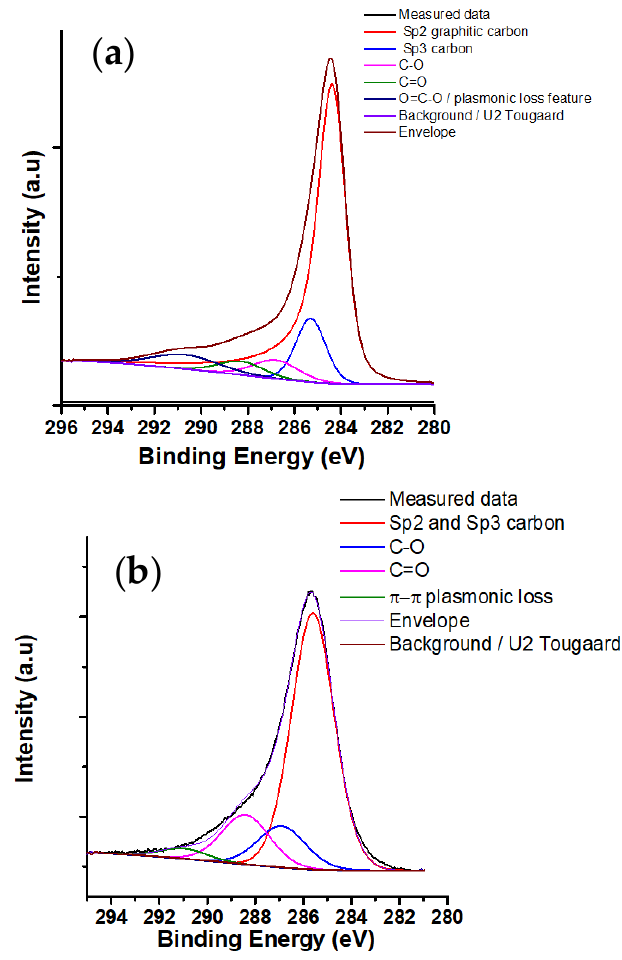
Figure 6. C 1s XPS spectrum of ( a ) CNP and ( b ) CNS.